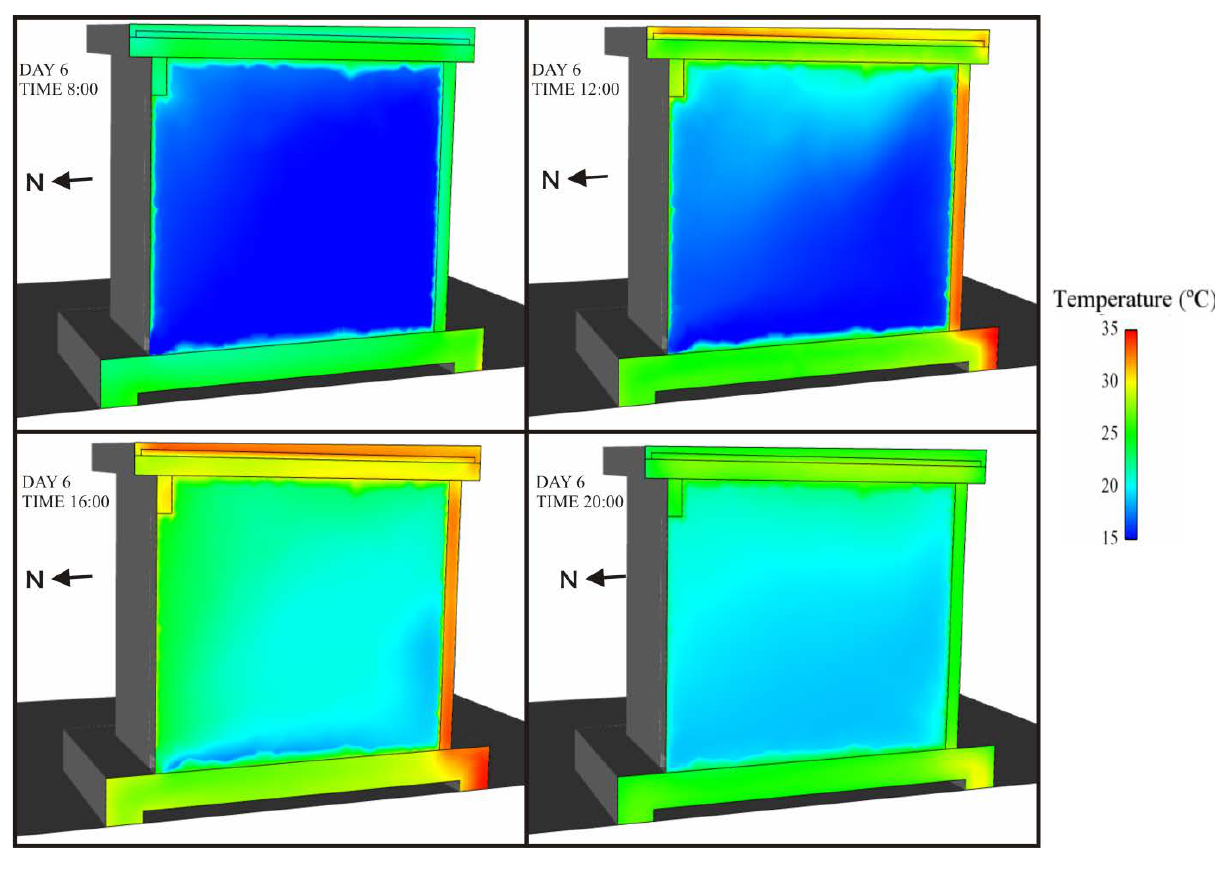
Figure 12. Evolution of the temperature field inside the cubicle and inside the